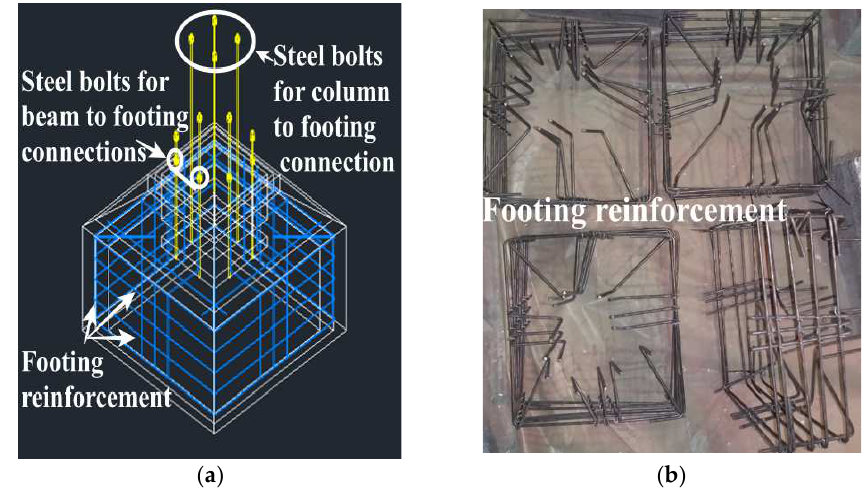
Figure 6. Footing reinforcement details: ( a ) AutoCAD details; ( b ) actual footing details. The structural beam has five steel reinforcement bars, two at the top in the compression zone and three at the bottom for the tension. The main reinforcements were tied up with a shear link of a 2 mm-diameter steel bar at 40 mm of spacing on the beam using cable ties, as shown in Figure 6. The steels bars with 6 mm-diameter and 5 mm-diameter were used for the slab’s longitudinal and transverse steel reinforcement. They were tied up with cable ties as shown in Figure 7, while Figure 8a,b presents the IBS components after casting. Also, Figure 9 shows the IBS components after casting.